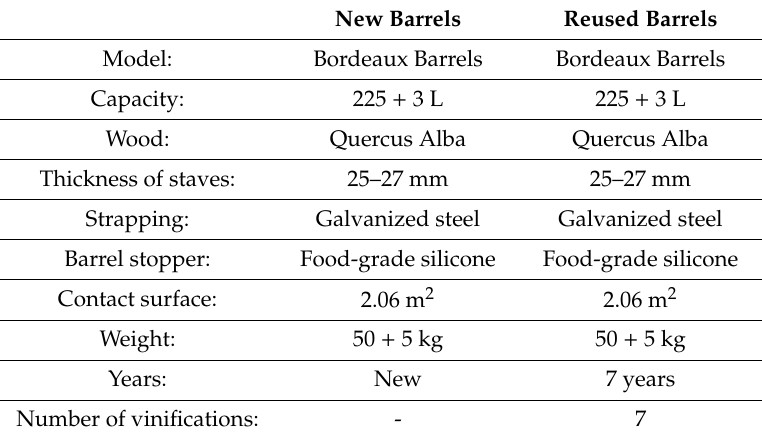
Table 2. Characteristics of used oak